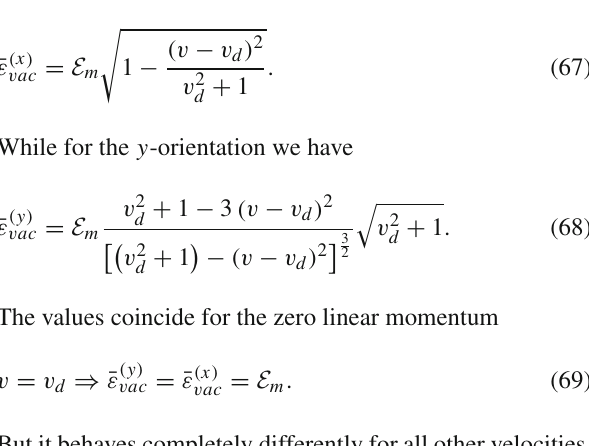
Being attractive for v 0 − < v < v 0 + and repulsive out this